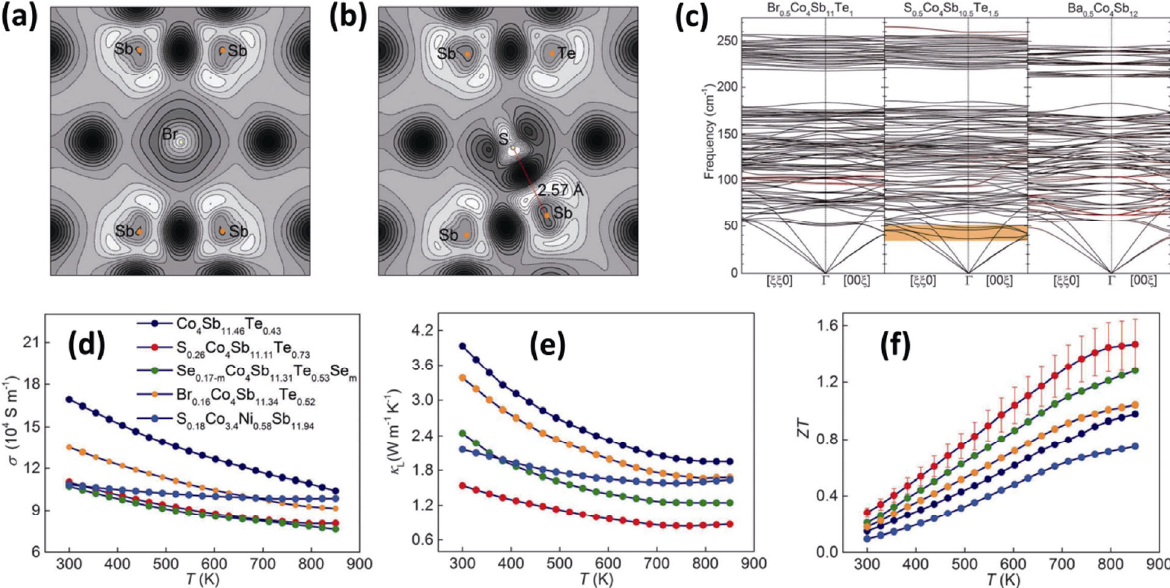
Fig. 4 CoSb 3 skutterudite TE materials with the electronegative guests. Calculated charge density difference at Sb four-ring plane in (a) Br 0.063 Co 4 Sb 12 and (b) S 0.063 Co 4 Sb 11.5 Te 0.5 ; (c) phonon spectra in filled skutterudites with electronegative guests. Temperature dependence of (d) electrical conductivity, (e) lattice thermal conductivity κ L , and (f) dimensionless figure of merit ZT for the electronegative guest filled CoSb 3 skutterudite materials. Reproduced with permission from Ref. [108], © The Royal Society of Chemistry